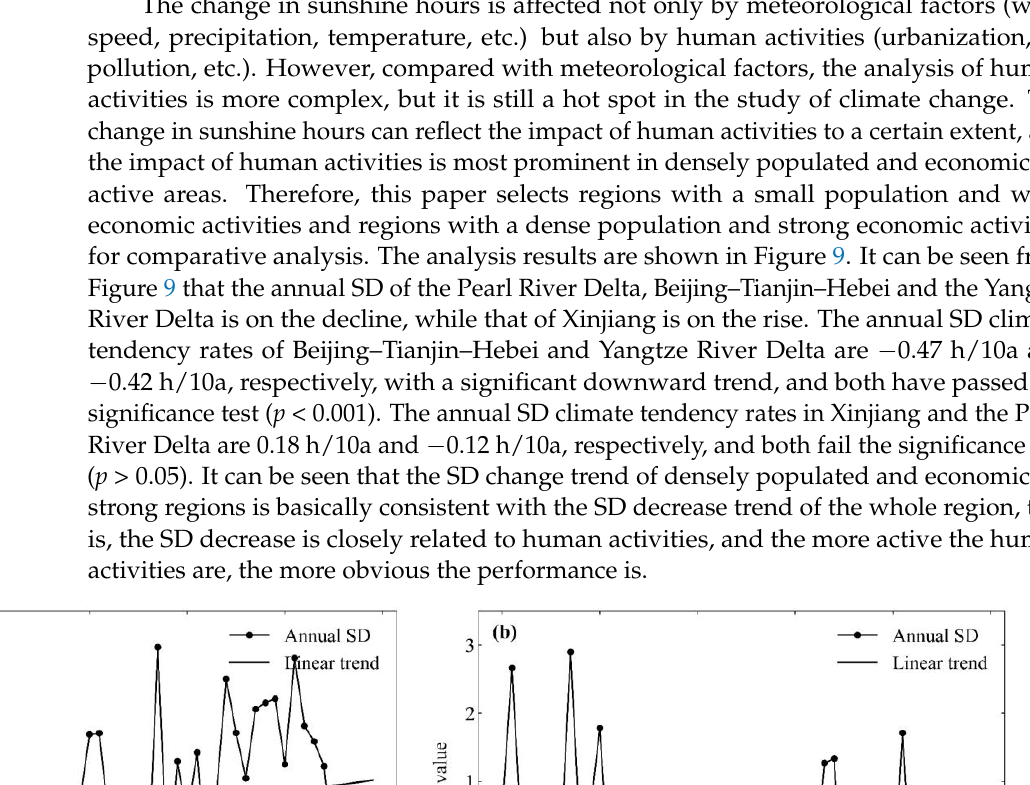
Figure 9. Inter-annual variations of SD in ( a ) Xinjiang, ( b ) Pearl River Delta, ( c ) Beijing-Tianjin- Hebei and ( d ) Yangtze River Delta. 4. Discussion The annual SD of China showed a downward trend from 1970 to 2019 and a signifi- cant downward trend after 1980, which is basically consistent with the conclusion of Wang et al. [29]. The seasonal SD shows a decreasing trend from 1970 to 2019, and the decreasing range is the largest in summer and the smallest in winter, which is basically consistent with the results obtained by Xia et al. [12]. In the early 20th century, the down- ward trend slowed down, which may be related to the “ early brightening ” of solar radia- tion [41]. From the perspective of space, SD gradually decreased from the western region to the southern region. The maximum annual SD is mainly distributed in northwest China, with an annual SD of more than 2700 h. The minimum annual SD is mainly dis- tributed in the south, especially in the Sichuan Basin and its surrounding areas, with the annual SD being less than 1200 h. This may be related to the latitude or altitude where the meteorological observation station is located, because, generally speaking, SD is relatively long in high-altitude or high-latitude areas [19]. By analyzing the influencing factors of SD change, it is found that there is a significant positive correlation between SD and wind speed, and the significant areas are mainly dis- tributed in the east and northeast, which is consistent with the results of Feng et al. [19]. As the east is a densely populated and economically developed area, and the northeast is